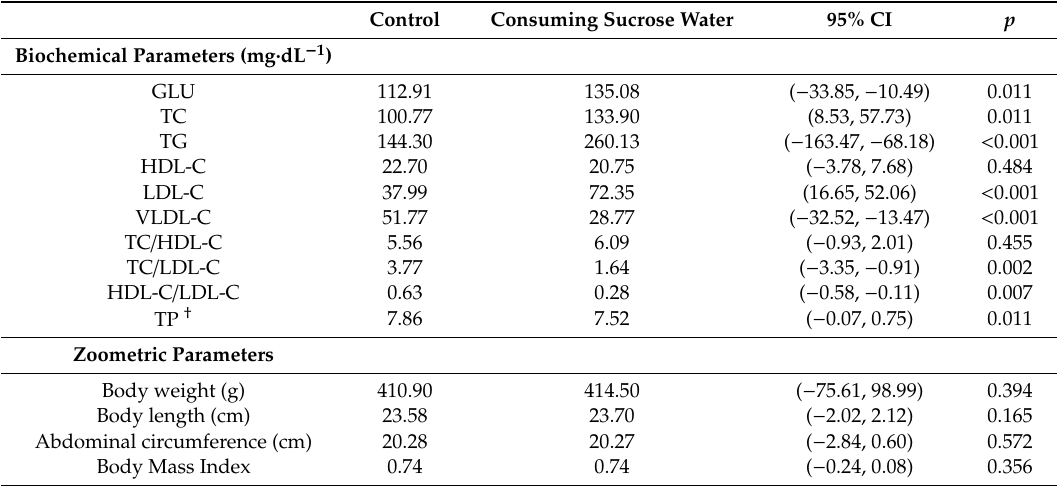
Table 2. Serum biochemical profile and zoometric parameters in control rats and rats consuming sucrose water for 23